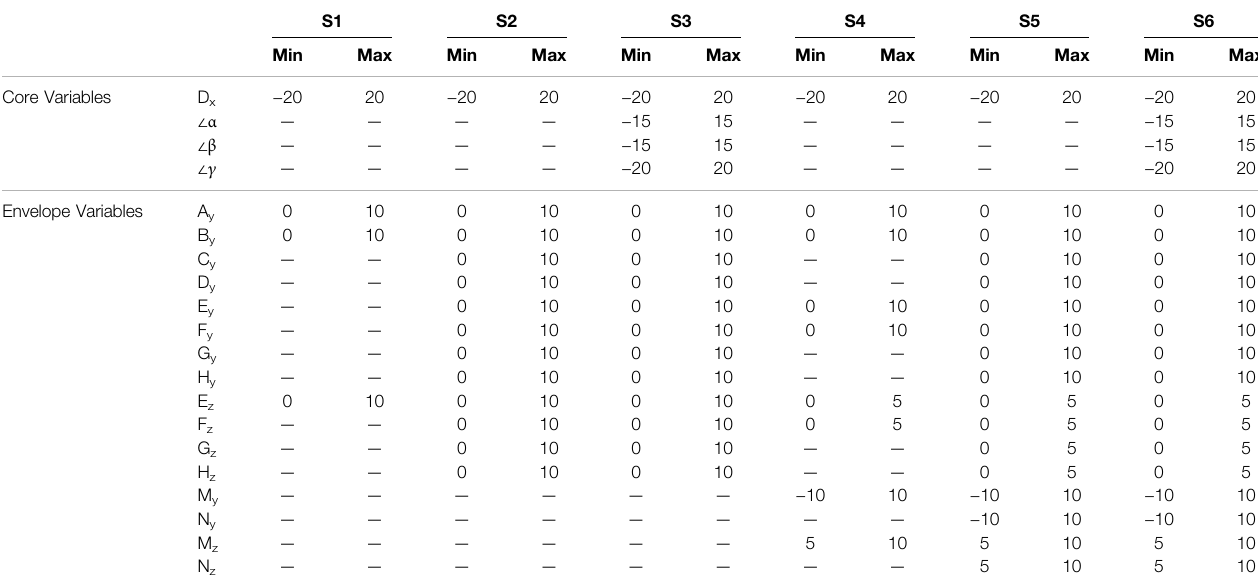
TABLE 2 | Domains of the shape